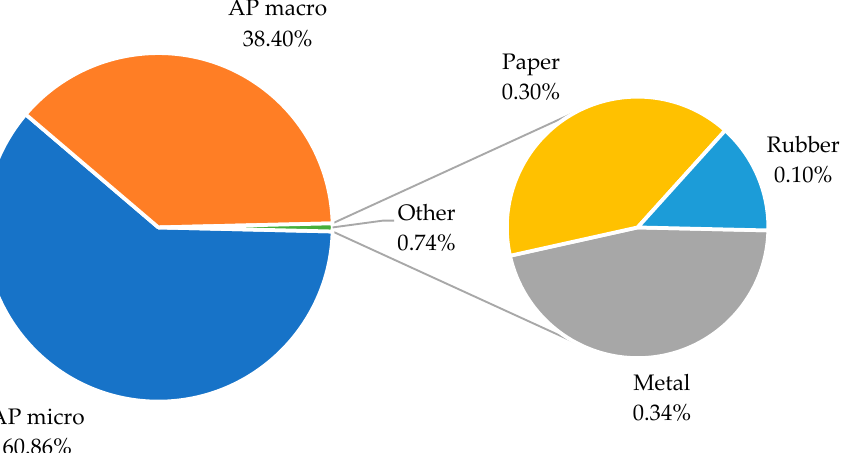
Figure 7. Ratio of collected marine litter by main categories.